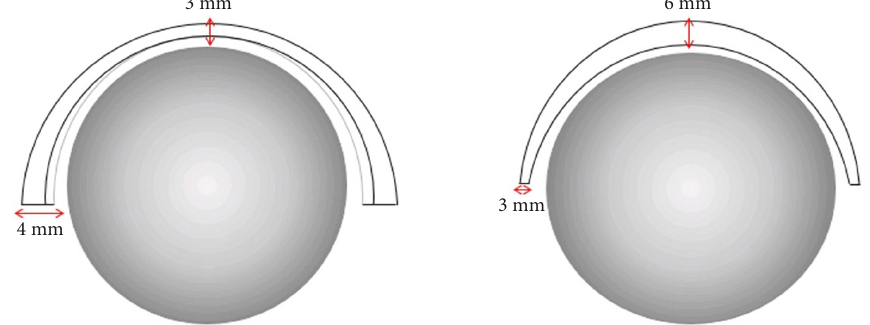
Figure 1: Implant design sketches. Corin (left) and Biomet (right) cup dimensions shown, with the gray sphere representing the femoral head.